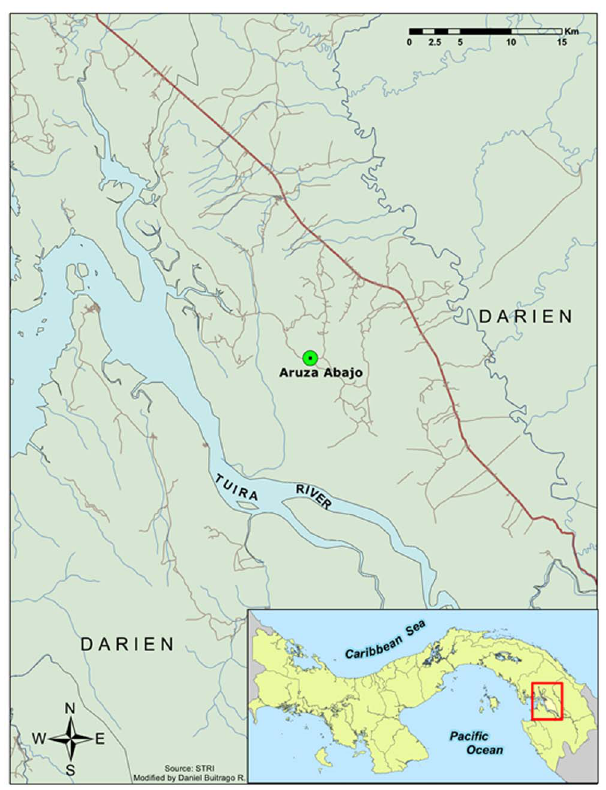
Figure 1. Map of Aruza Abajo study site in western Darien Province (Panama).